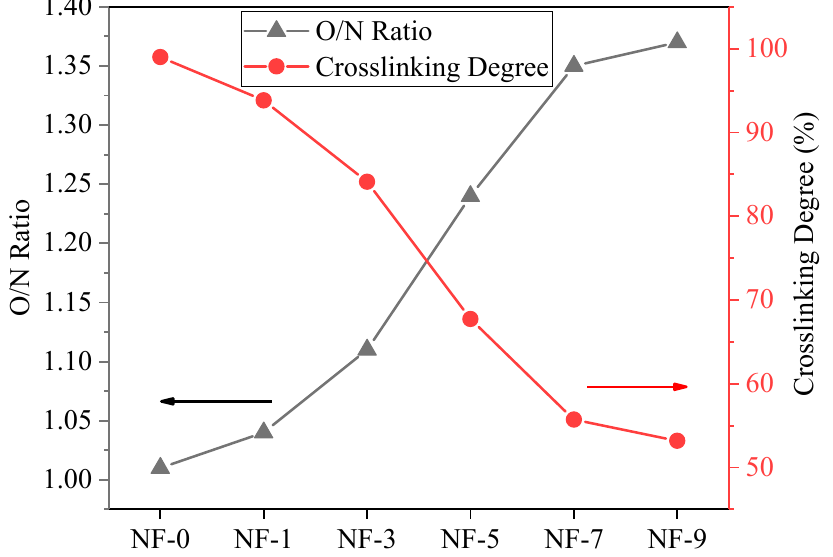
Figure 3. O/N ratio and crosslinking degree of NF membranes with different DWCNT dosages.